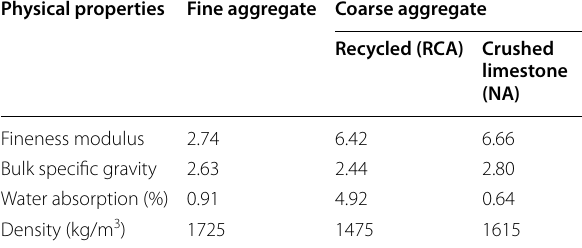
Table 2 Physical properties of